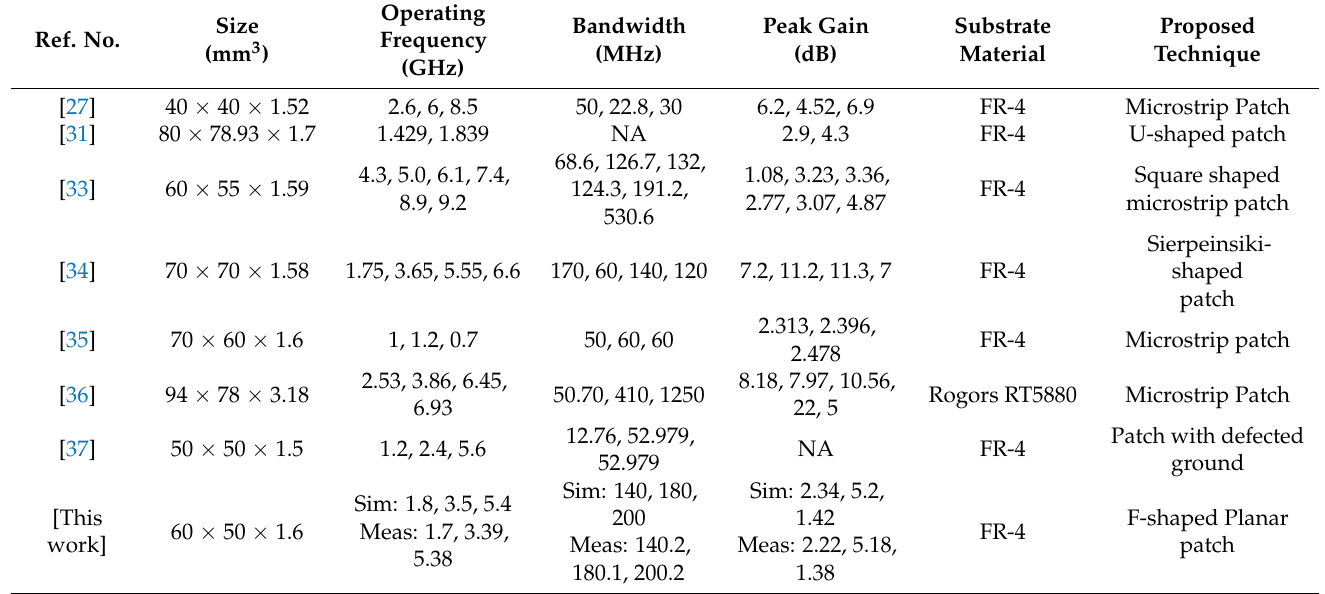
Table 3. Comparison of the proposed antenna to other multiband